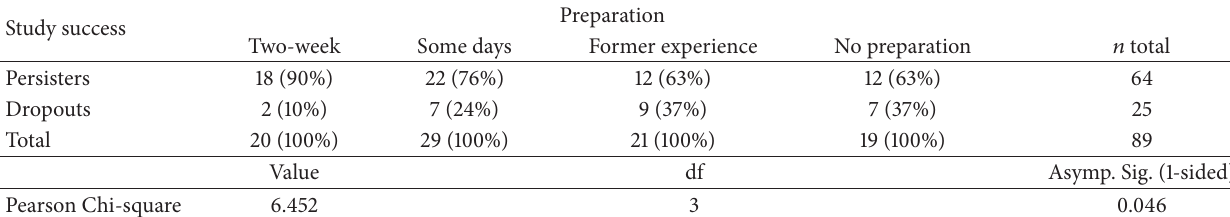
Table 12: Study success following different preparatory programs of different intensity ( 𝑛 = 89